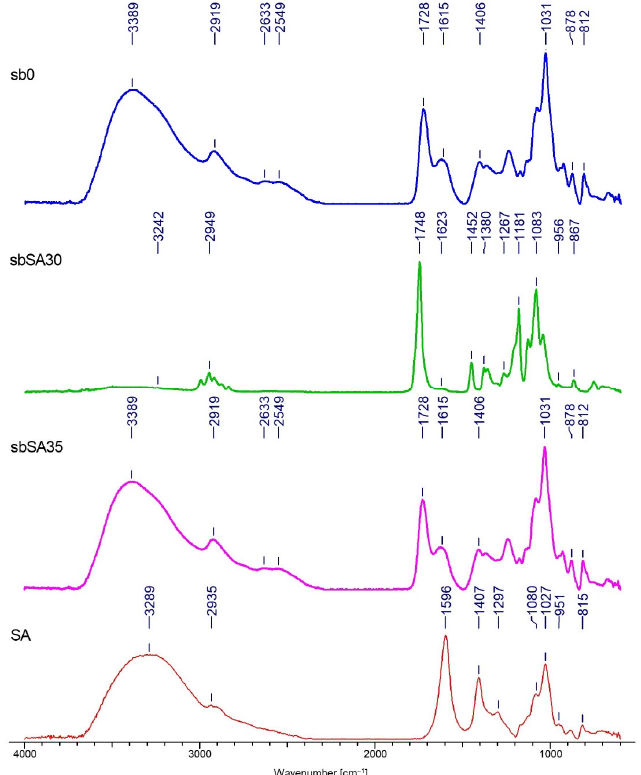
Figure 9. FTIR spectra of the spun-bonded PLA nonwoven fabrics with deposition of the sodium alginate layer (SA): sb0—reference sample (spun-bonded PLA nonwoven); SA—powder of sodium alginate.